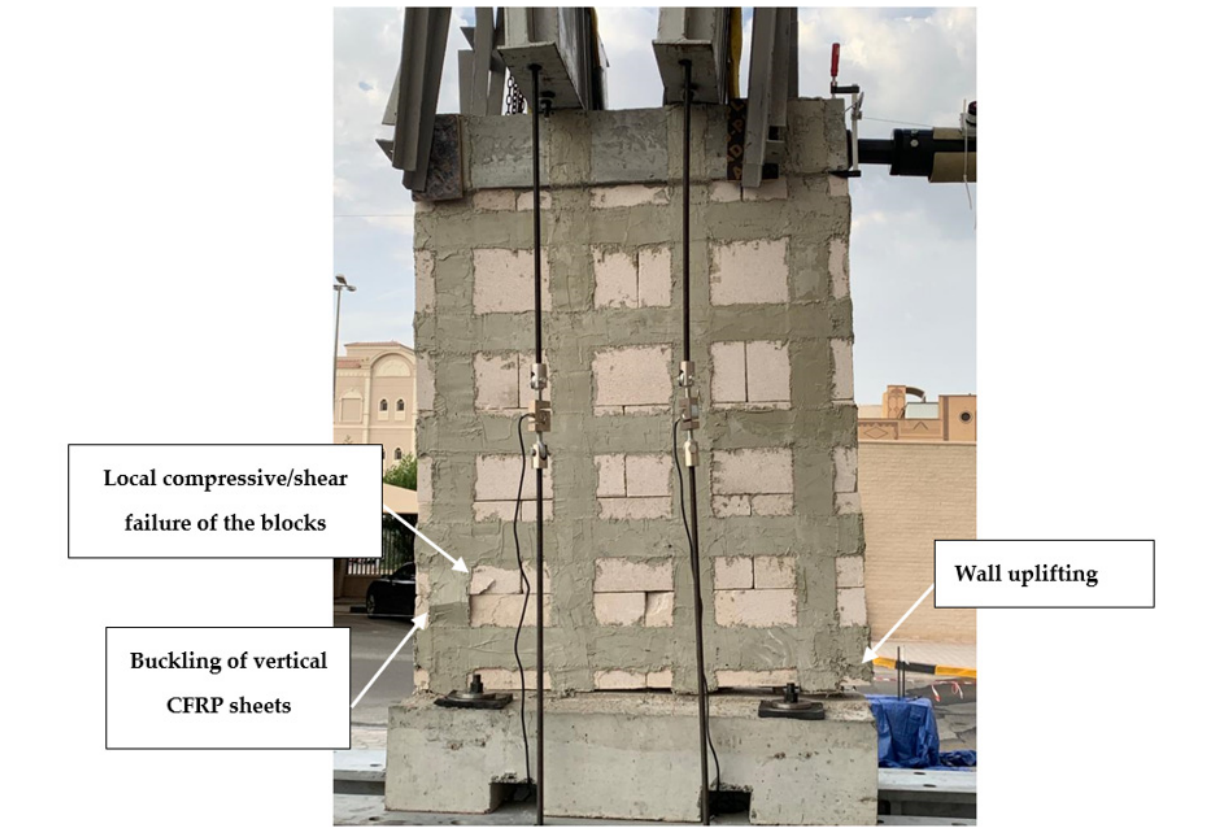
Figure 15. Failure of the unreinforced wall ( a ) on the compression side and ( b ) on the tension side.